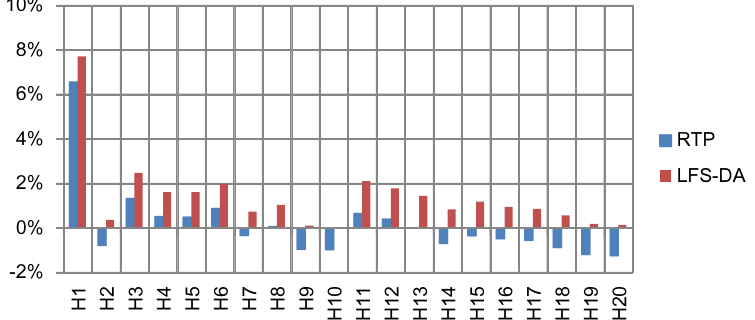
Figure 7. Rate of increase of each agent’s welfare compared with the without trading condition.